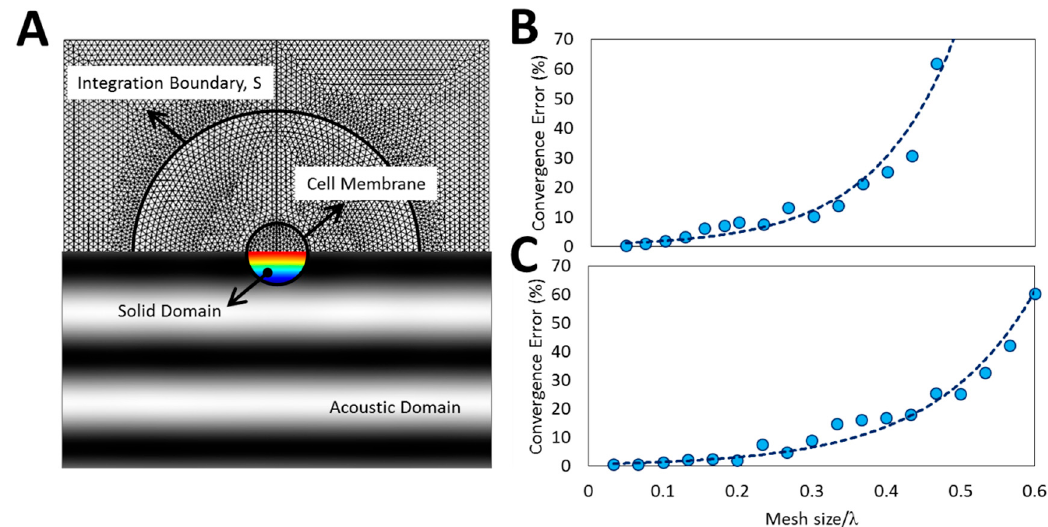
Figure 2. Mesh dependency analysis and convergence of finite element model (FEM) results. ( A ) Computational mesh structure for the acoustic solid interaction (ASI) model. An appropriate mesh size is selected based on the acoustic wavelength to comply with the gradients of deformation (color map inside solid domain) and acoustic pressure fields (gray-scale map of acoustic domain); ( B , C ) Convergence analysis of the ARF using Equation (9) for ( B ) ASI and ( C ) 2D model with proposed formulation (Equation (10)). For all simulations, a fine mesh (mesh size/ λ = 1/15) was chosen to ensure the results accuracy. The graphs demonstrate that the proposed formulation has a better convergence with respect to the ASI model.